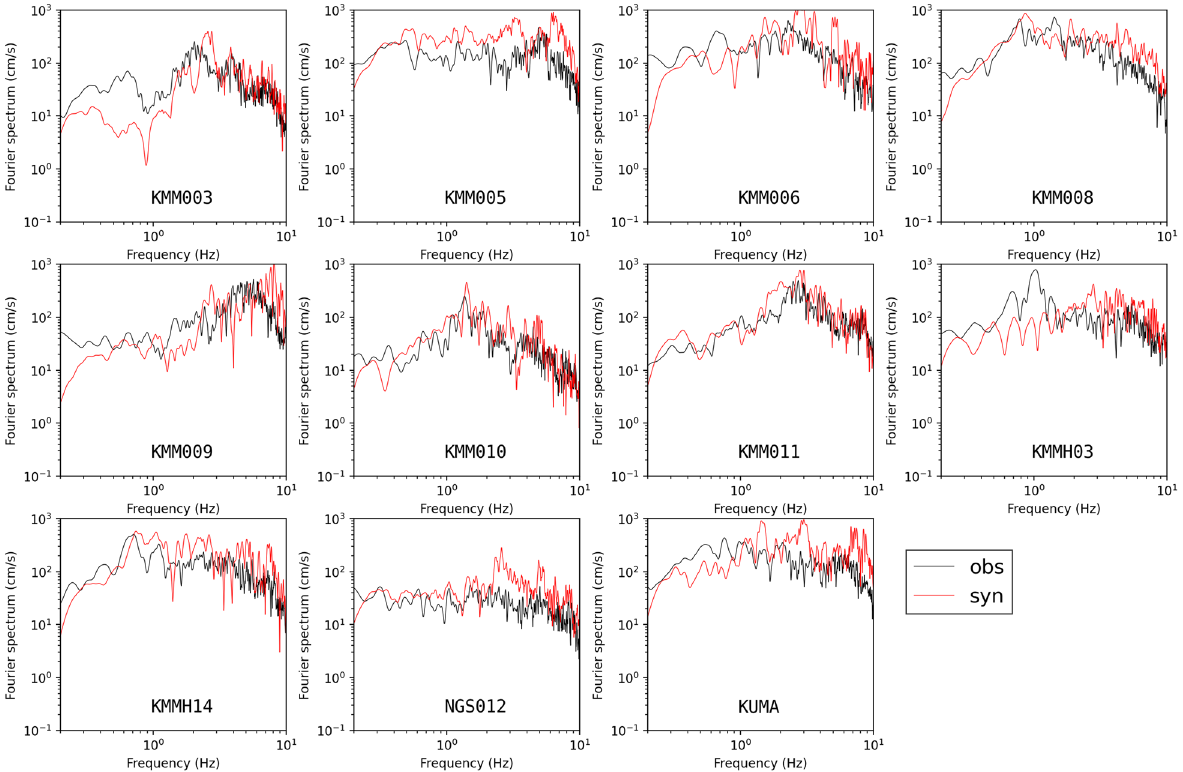
Fig. 12 Synthetic and observed Fourier spectra of the reference case for the earthquake of 2016/04/16 01:25 ( M w 7.1). Black lines indicate the observed Fourier spectra. Red lines indicate the synthetic Fourier